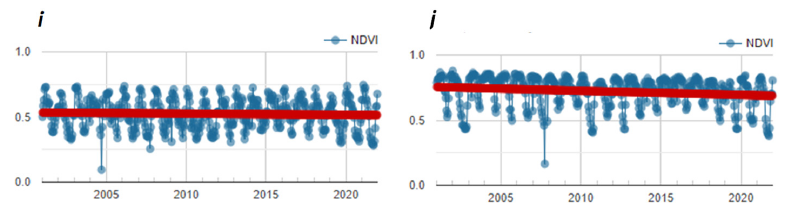
Figure 4. Trends in NDVI time series in forested and deforested areas in the Chiquitania region (2001–2021). The red line represents the trend line of the data points. Sites with intact forest: ( a ) Noel Kempff, ( b ) Bajo Paraguá, ( c ) Monteverde, ( d ) San Rafael, and ( e ) Tucabaca. Sites with deforestation: ( f ) San Ignacio, ( g ) Concepción, ( h ) El Cerro/California, ( i ) Nueva Esperanza, and ( j ) Santa Ana/Buena Vista.